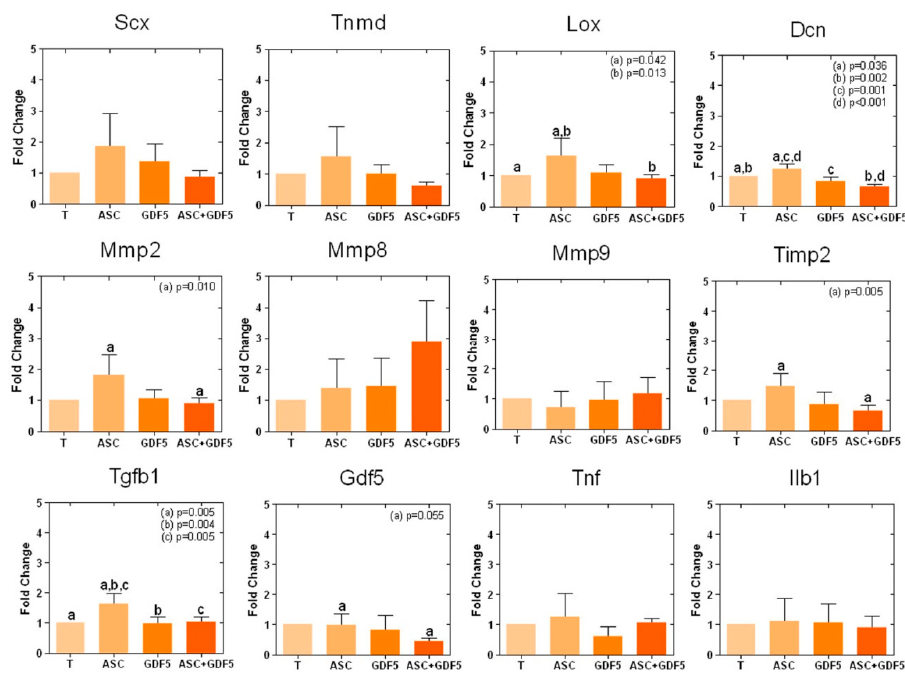
Figure 4. RT-PCR array for expression analysis of 12 genes in transected tendons: 50% of the genes analyzed were altered. The ADMSC increased expression of Lox , Dcn , and Tgfb1 when compared to the other groups. Compared only to the ASC+GDF5 group, ADMSC increased the expression of Mmp2 , Timp2 , and Gdf5 . The same letter between the groups corresponds to a significant difference between them.